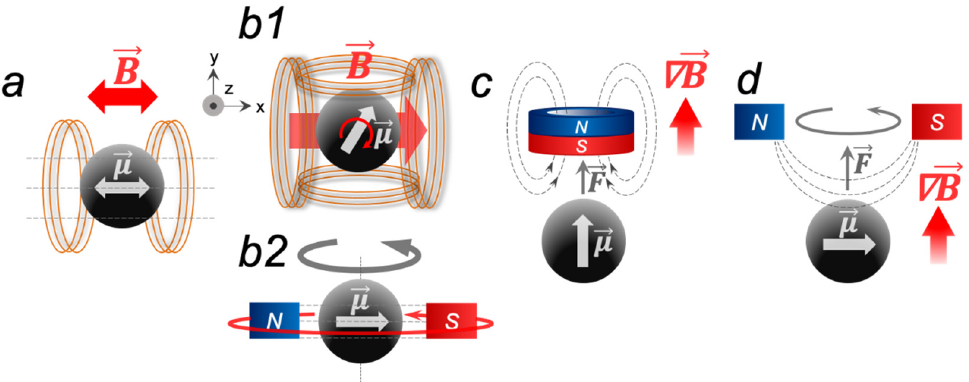
Figure 1. Different routes of an MNP activation by external MFs. In such fields, the magnetic mo- ment 𝜇⃗ of an MNP aligns with the field vector 𝐵(cid:4652)⃗ : ( a ) uniform AMF; ( b1 ) RMF implemented by the two-axis perpendicular Helmholtz coils 90°, out of phase with each other; ( b2 ) RMF implemented by two permanent magnets that rotate mechanically; ( с ) SMF with the filed gradient ∇𝐵(cid:4652)⃗. ( d ) The combination of ( b2 ) and ( c ).